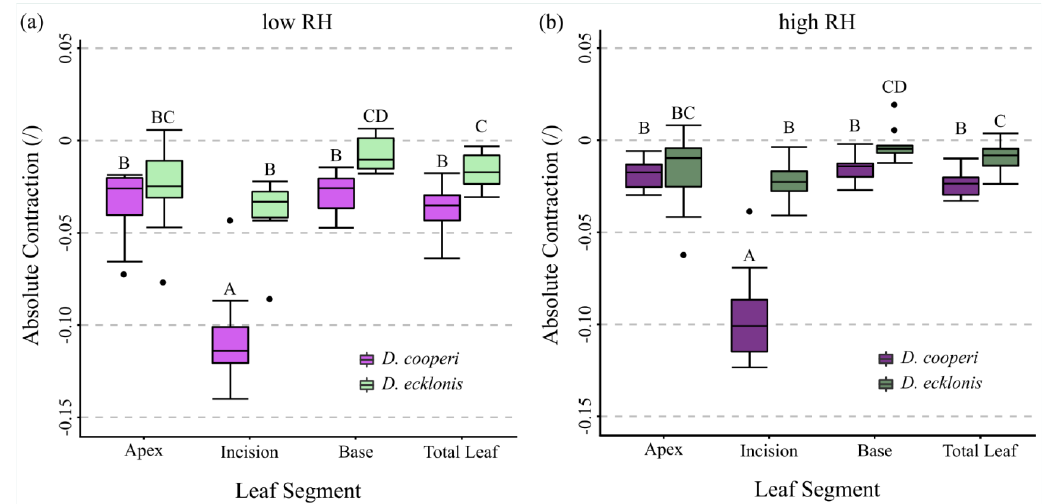
Figure 8. Statistical analyses of the self-sealing kinematics of D. cooperi and D. ecklonis at two di ff erent RH levels. Segment-specific comparison of the absolute contractions for both D. cooperi and D. ecklonis seen at ( a ) low RH and ( b ) high RH. Each boxplot resembles a sample size of n = 10. Statistical annotations are given above each boxplot. Light-colored and dark-colored boxplots represent data measured at low ( D. cooperi : 44.0%; D. ecklonis : 43.6%) and high ( D. cooperi : 59.6%; D. ecklonis : 57.3%) RH levels, respectively. Purple boxplots indicate the leaf kinematics of D. cooperi , whereas green boxplots highlight the results of D. ecklonis